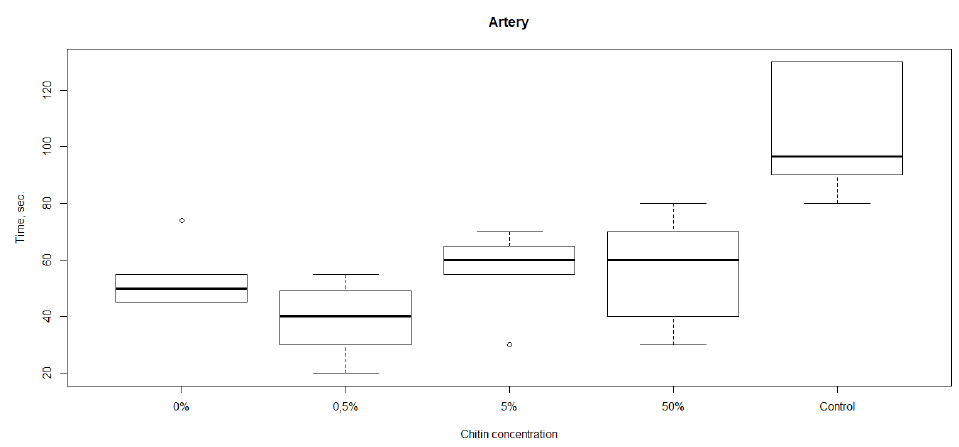
Figure 3. Rates of bleeding arrest (time until cessation of bleeding) in the experiments with chitosan sponges containing different amounts of ChNF.